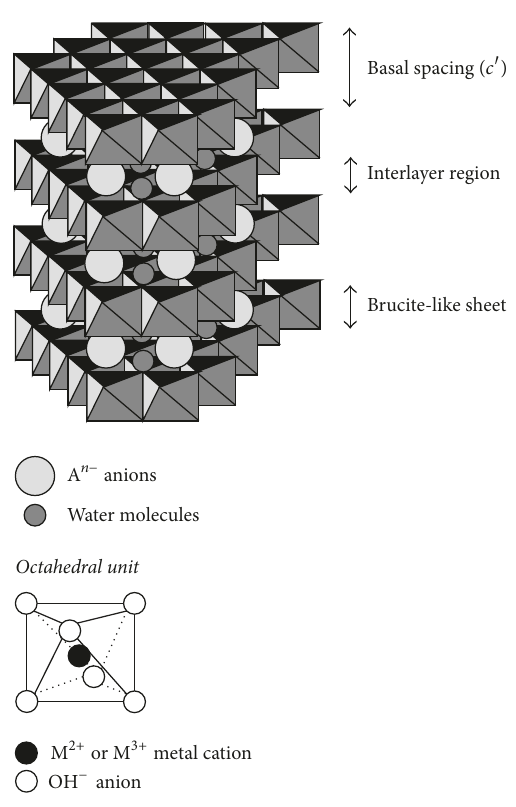
Figure 1: The molecule structure of LDHs